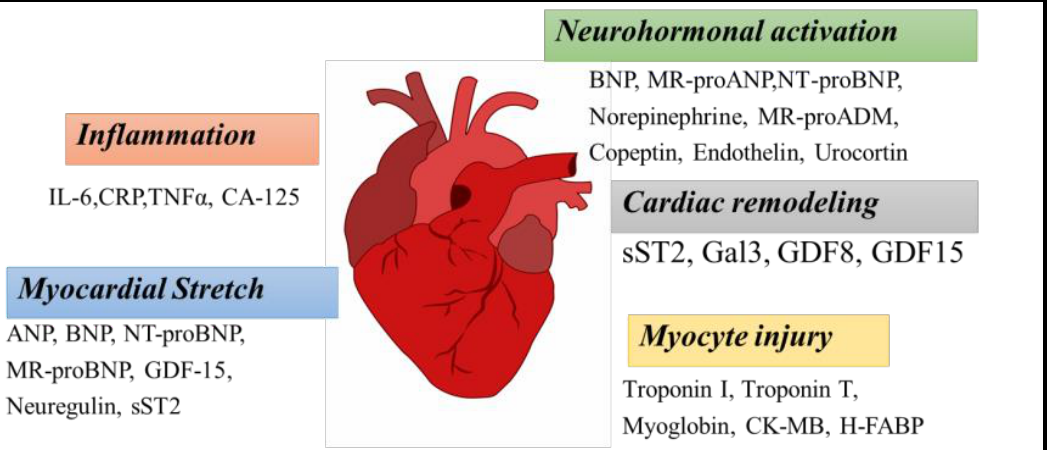
Figure 1. Overview of the heart failure (HF) biomarkers.